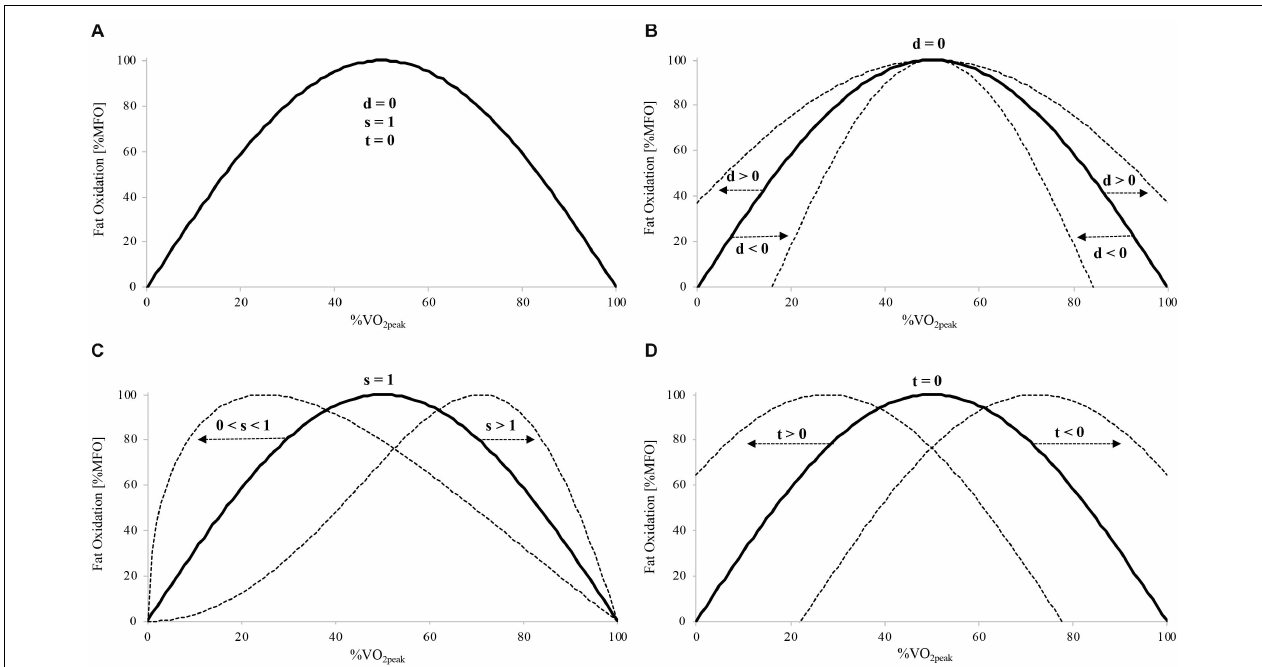
FIGURE 1 | Schematic illustration of the three independent variables of the SIN model (dilatation [d], symmetry [s], and translation [t]) and their impact on the whole-body fat oxidation kinetics. Basic symmetric SIN curve with d = 0, s = 1, and t = 0 (A) . Changes in d (B) , s (C) , and t (D) and corresponding modifications in the basic symmetric SIN curve (dotted lines). MFO, maximal fat oxidation; ˙ VO 2 peak , peak oxygen uptake.